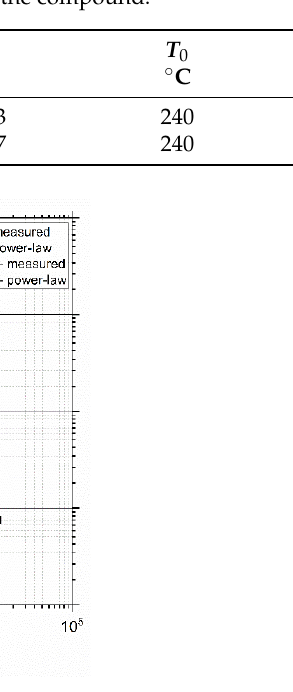
Table 2. Power-law parameters of the polymer and the compound.